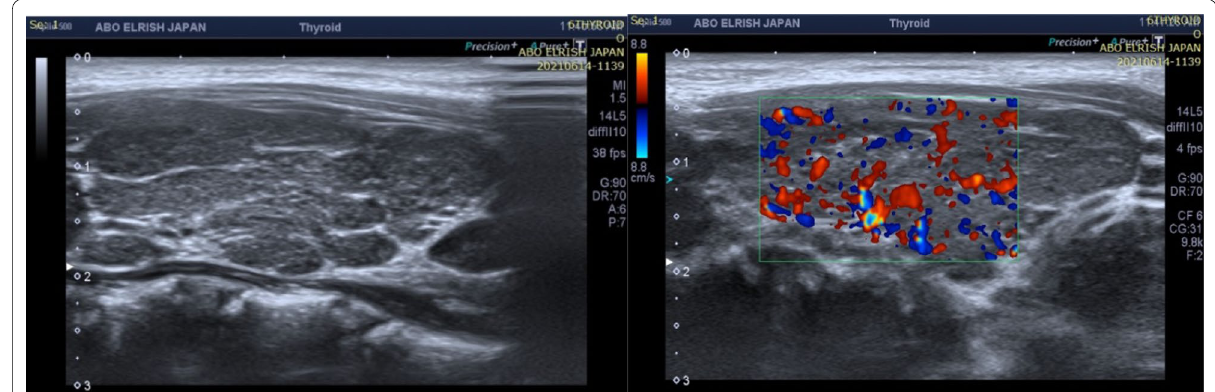
Fig. 3 Thyroid Ultrasound of a 13 years old female with history of neck swelling since 4 years, positive TPOAb and TGAb, T4 1.6, T3 3.1 and TSH 6.8 under medication with tab. Carbimazole and diagnosed as Grave’s disease. The gland shows increased size of right lobe with coarse echotexture, hyperechoic septations giving pseudonodular appearance with few scattered micro hypoechoic nodules and increased vascularity